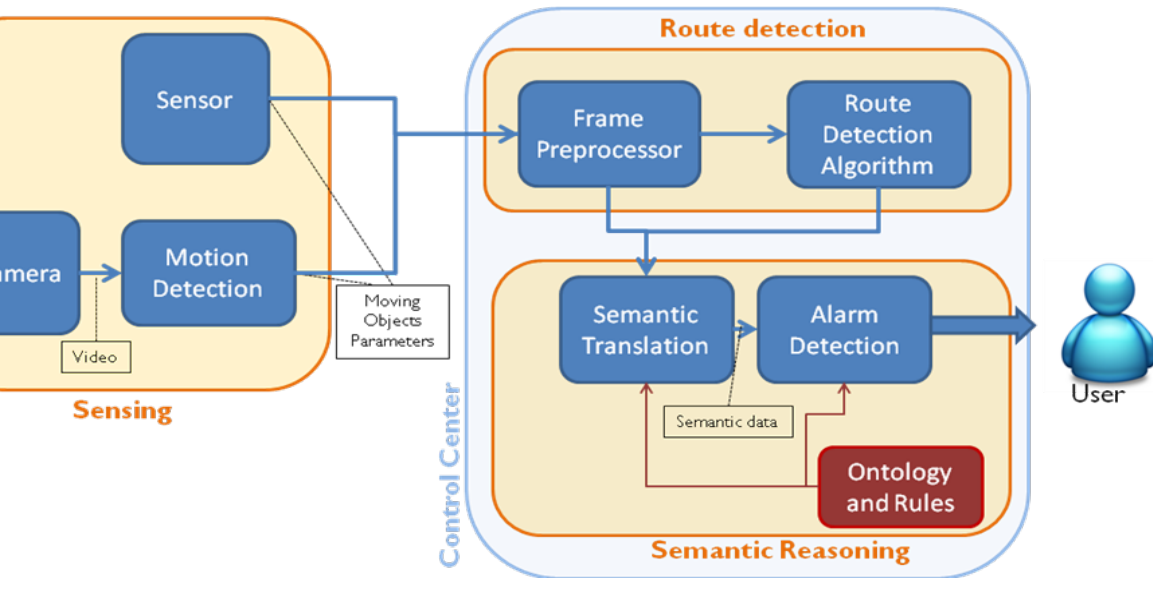
Figure 1. Basic scheme of the proposed surveillance